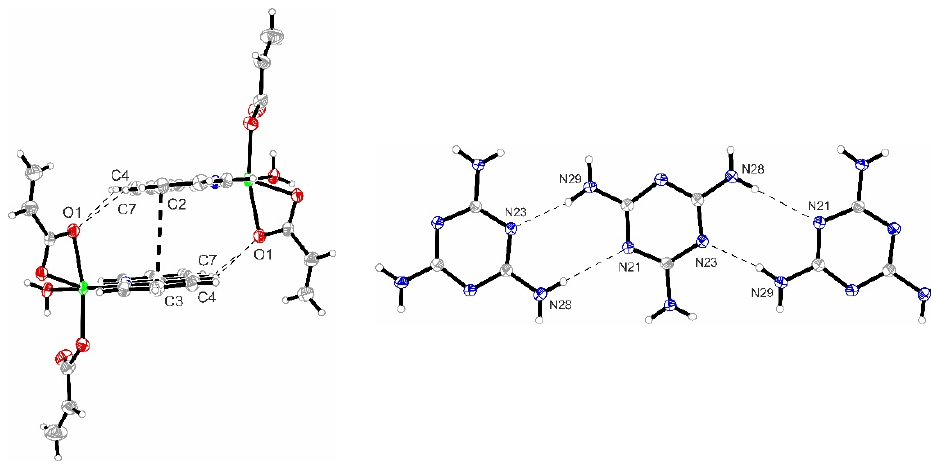
Figure 2. Dimer type formation between two complex molecules involving C-H ... O and π ... π interactions ( left ), and linear chains formation along the b -axis through N-H ... N hydrogen bonds interactions between the melamine ligands ( right ).